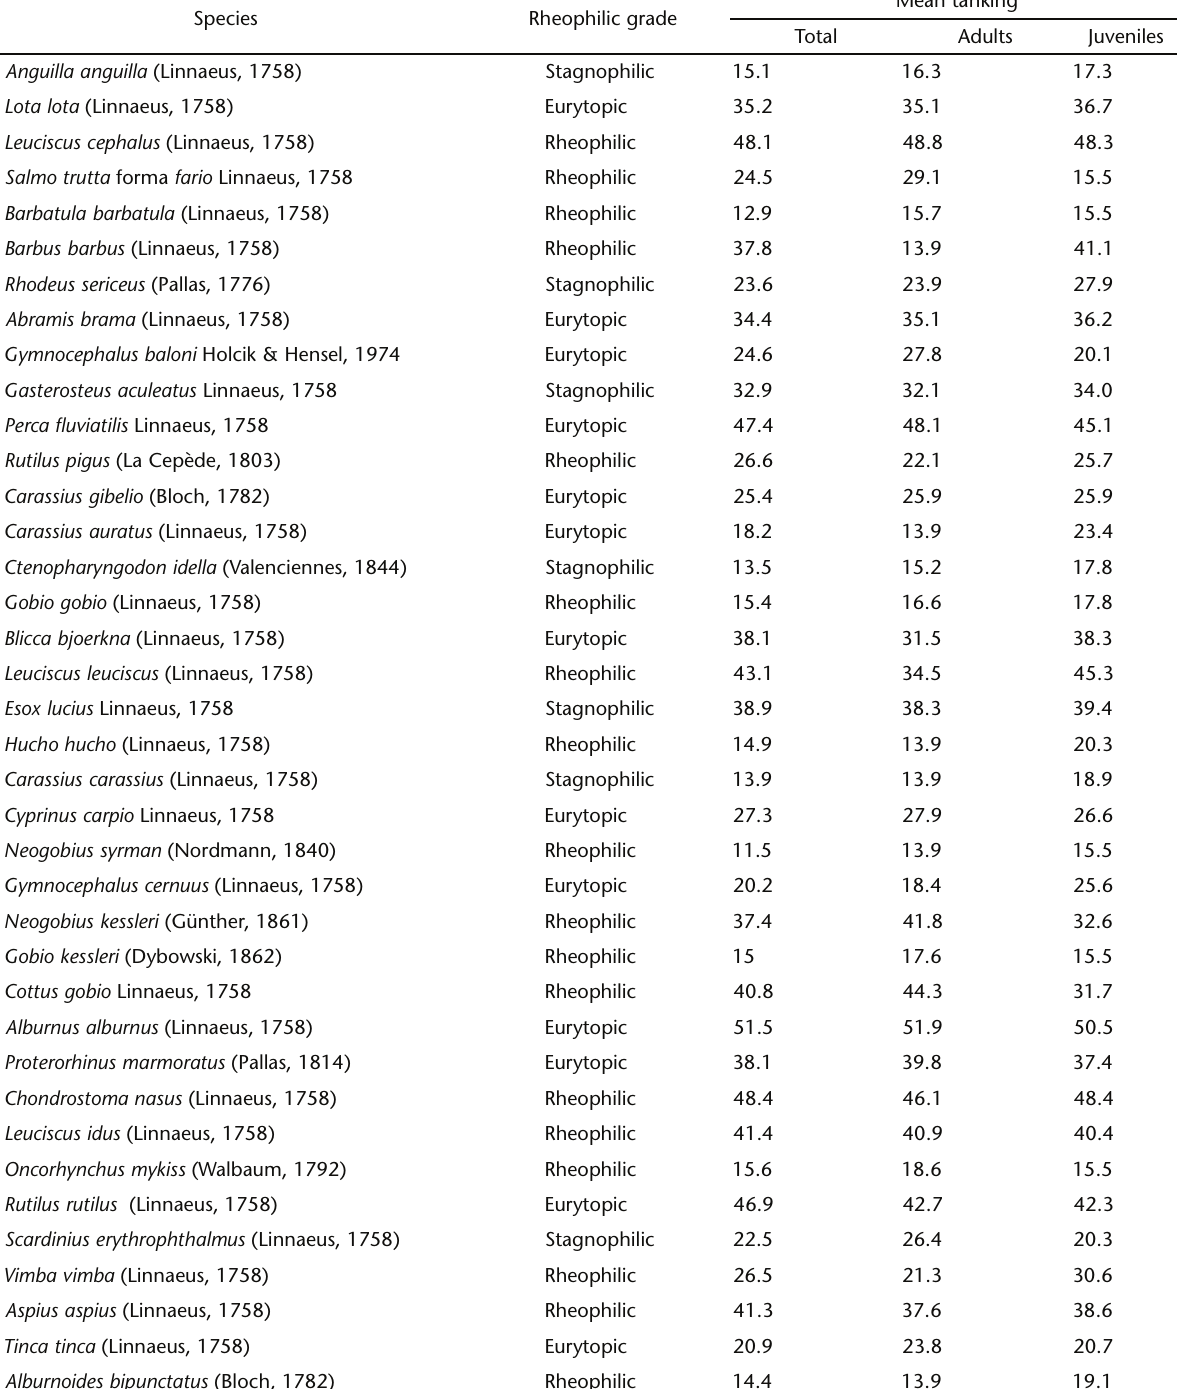
Table II. Compared Mean Rankings of fish ages. Greater divergences are marked. Species Rheophilic grade